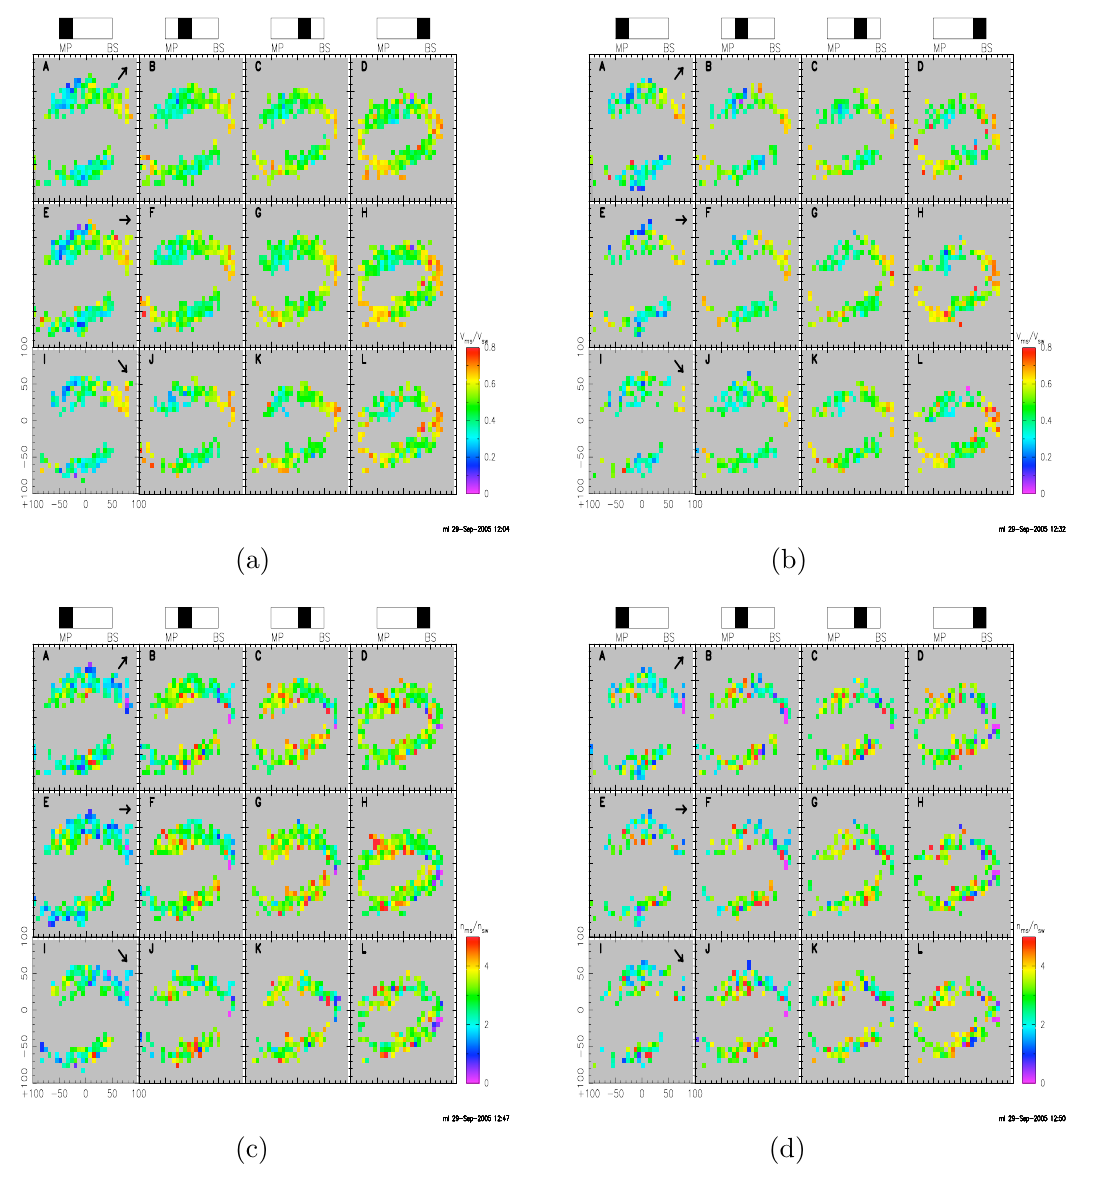
Fig. 8. Parker and ortho-Parker IMF subsets of the survey data set: Illustrated are the velocities (a) and (b) and densities (c) and (d) for the 4 radial cross-sections of the magnetosheath. The magnetosheath sector represented by a panel is indicated at the top of each of the four panel columns by a shaded box which shifts from left to right as the sector progresses outwards from the magnetopause to the bow shock boundary. The top panels (A − D), bottom panels (I − L) and middle panels (E − H) represent northwards, southwards and equatorial IMF respectively .